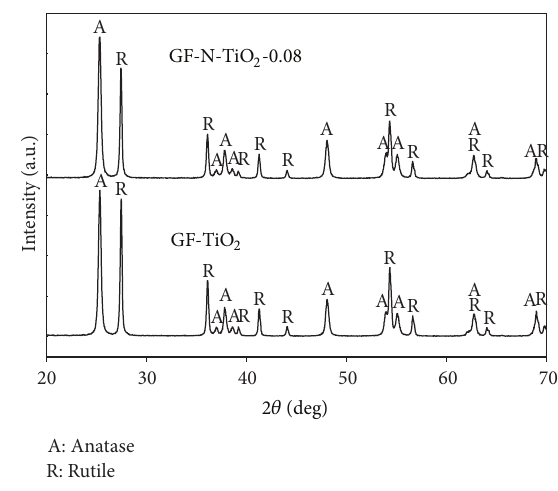
Figure 4: X-ray diffraction patterns of GF-N-TiO 2 with a N-to-Ti ratio of 0.08 (GF-N-TiO 2 -0.08) and GF-TiO 2 .